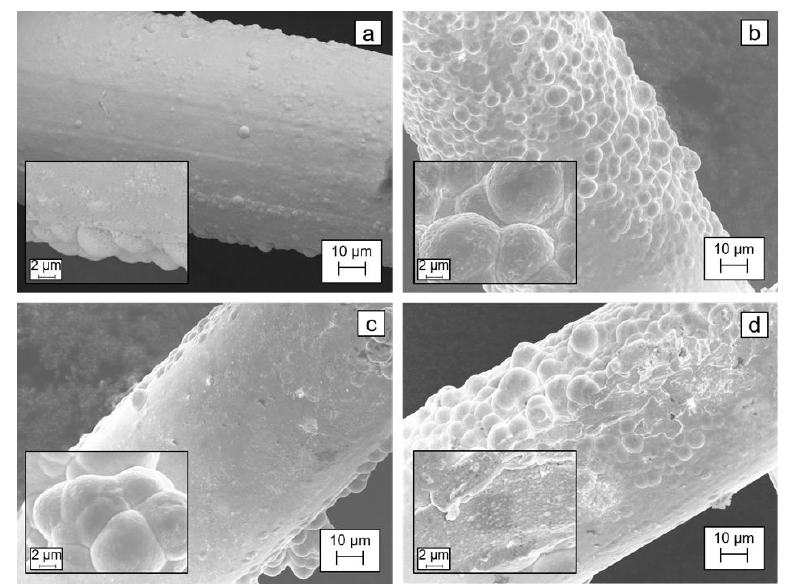
Figure 6. SEM images of ( a ) unused silver mesh, and after tests with ( b ) acidic anolyte, ( c ) neutral anolyte, and ( d ) alkaline anolyte.